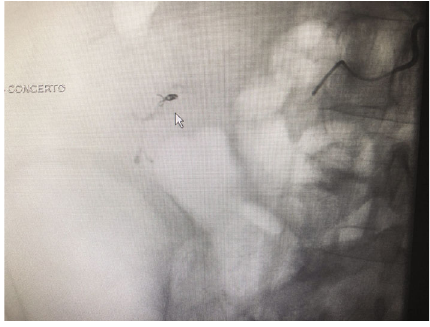
Figure 3: Digital subtraction angiography screenshot for the fi rst patient after embolization was completed; the white arrow points towards the coiled blood